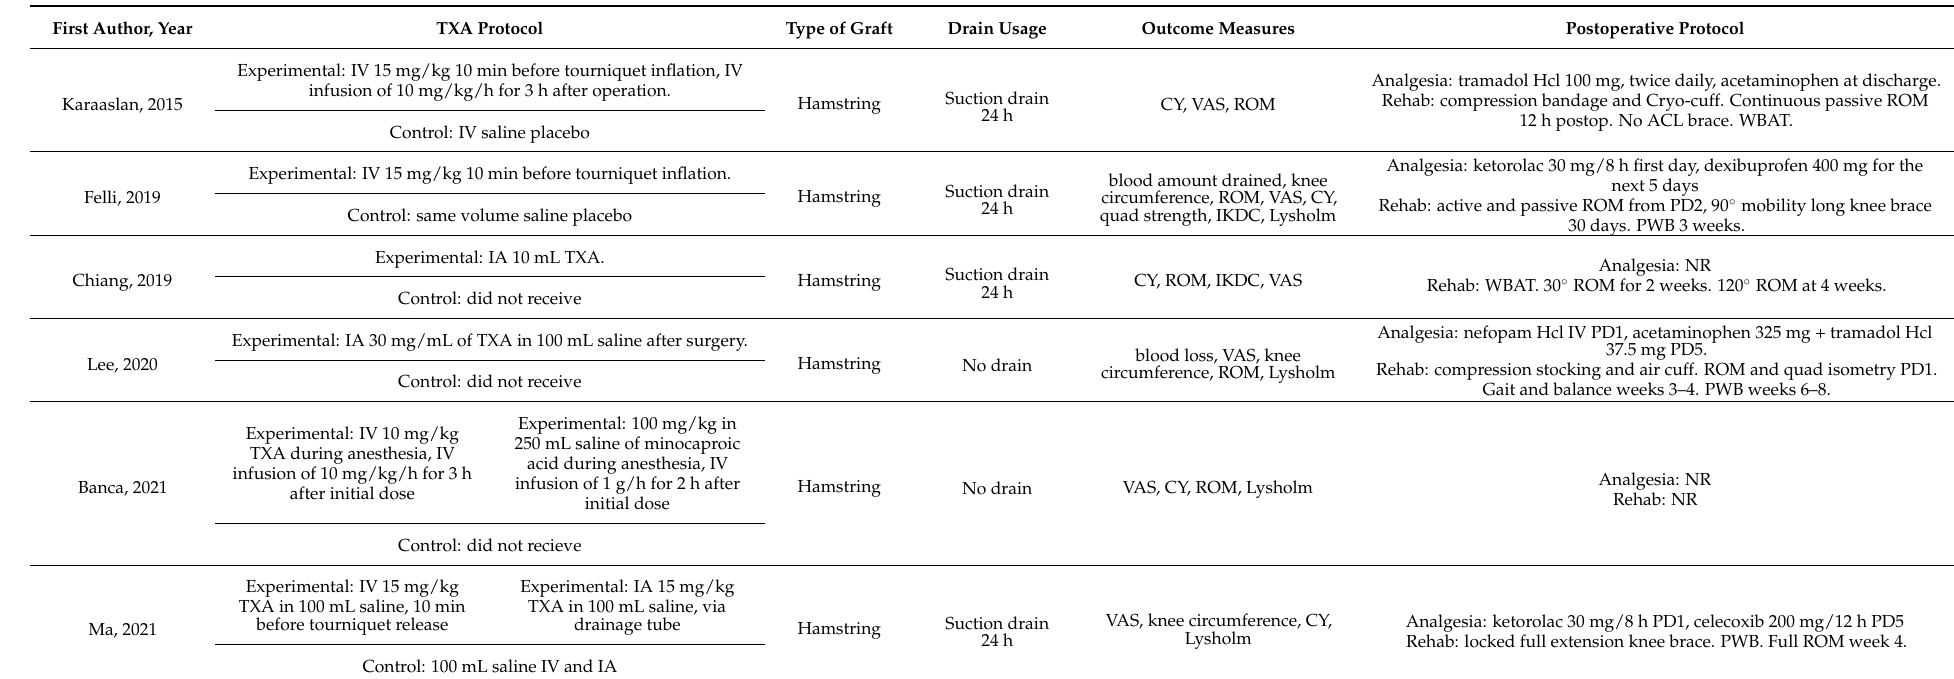
Table 2. Study design characteristics of all included